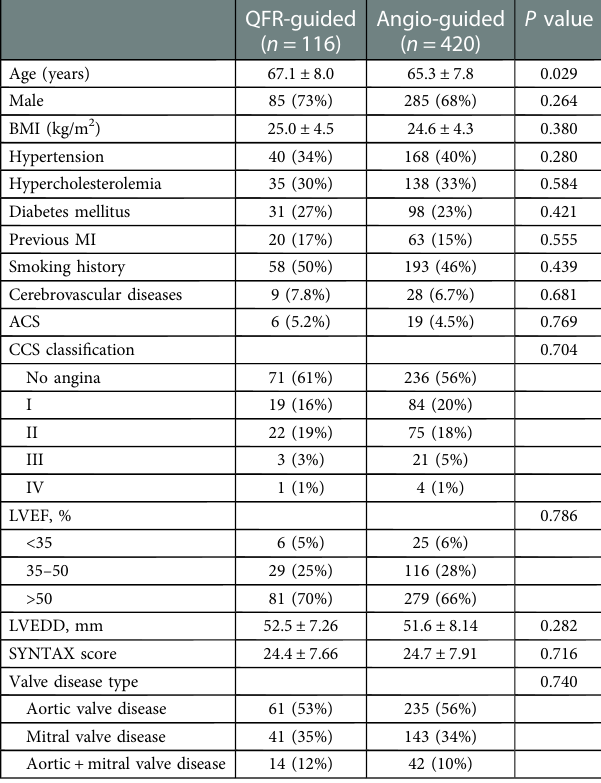
TABLE 1 Baseline characteristics of the study population pre-PSM.